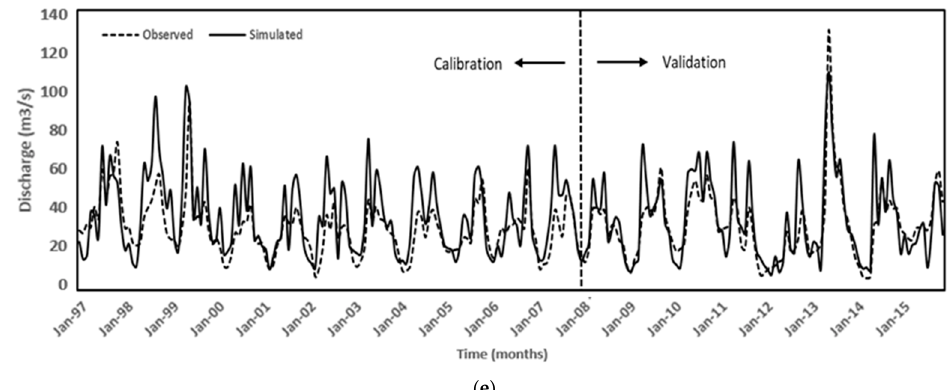
Figure 5. Monthly simulated and observed streamflow discharge for calibration at Hanwella: ( a ) Hanwella; ( b ) Deraniyagala; ( c ) Glencorse; ( d ) Holombuwa; ( e ) Kithulgala. Table 5. SWAT model calibrated parameters (Hanwella sub-basin).